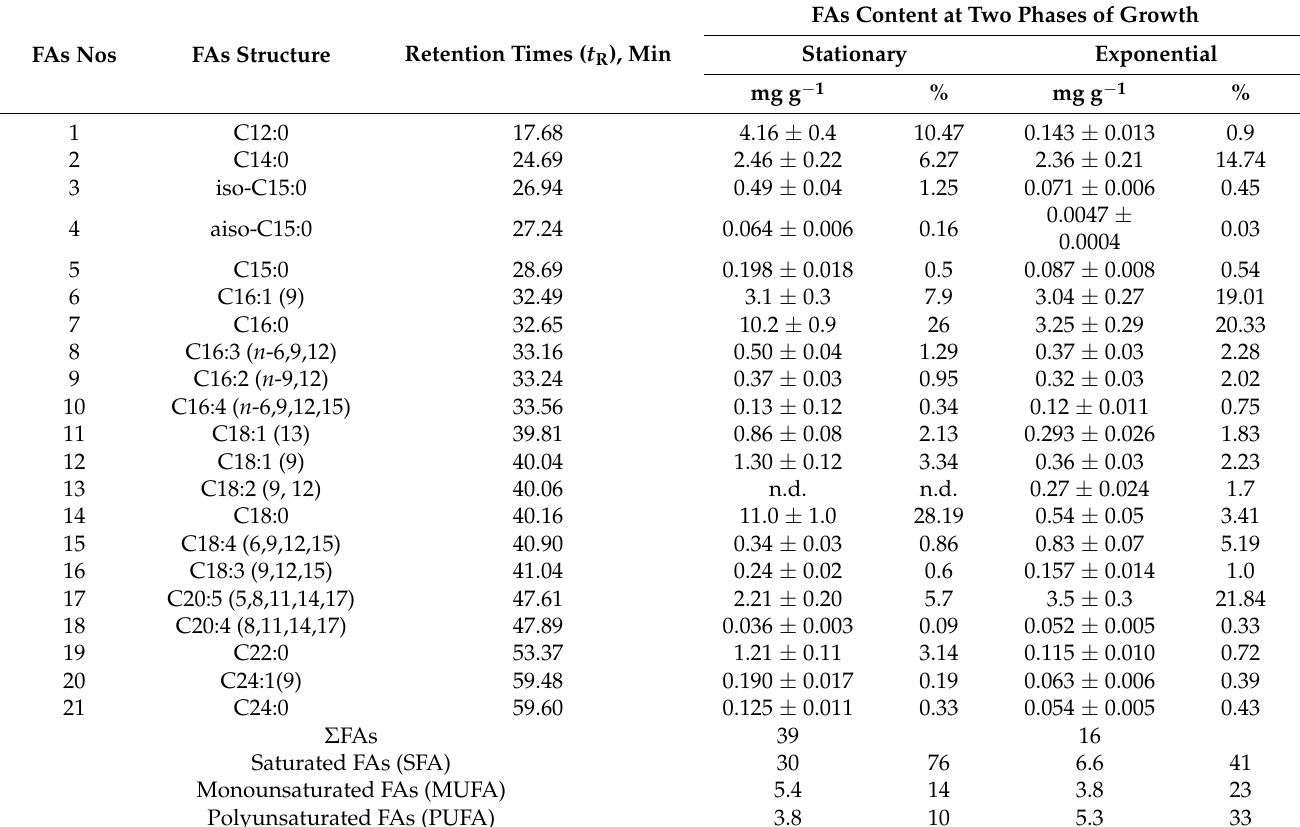
Figure 4. E . cf. paludosa FAMEs extract GC-FID-chromatogram fragment. ( A )—stationary phase of growth; ( B )—exponential stage. Figure 4. E. cf. paludosa FAMEs extract GC-FID-chromatogram fragment. ( A ) — stationary phase of growth; ( B ) — exponential stage. Table 1. The results of E. cf. paludosa FAMEs analysis by Table 1. The results of E. cf. paludosa FAMEs analysis by GC-FID.